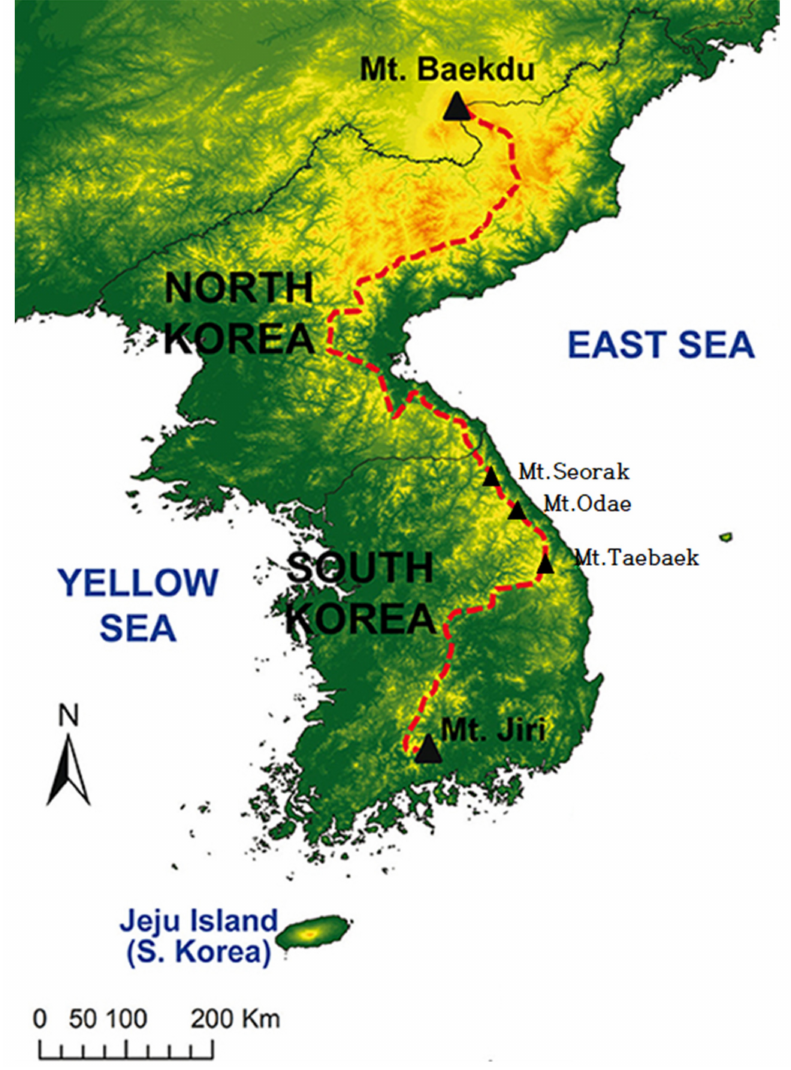
Figure 2. The Baekdudaegan Mountain Region in Korea (Modified from: Chung et al., 2018 [22]). The Baekdudaegan Mountain Region is the “backbone” in Korean Peninsula. It stretches across the Korean peninsula and is a well-known biodiversity hotspot, harboring 1500 plant species (in the South Korean